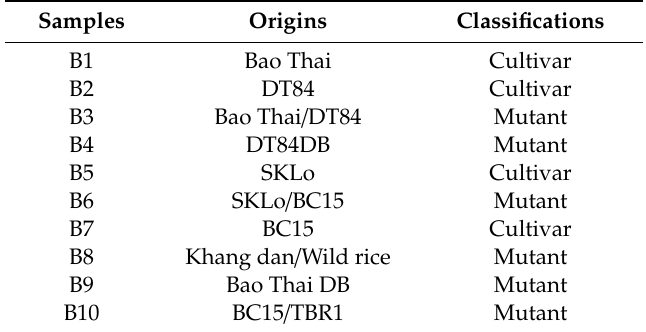
Table 1. The origins and classifications of rice cultivars and mutant lines. Samples Origins